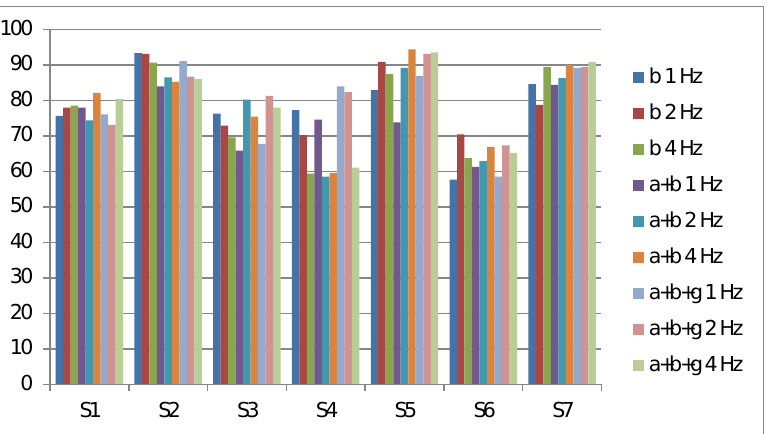
Figure 4. Accuracy comparison for each subject with different types of features. In the legends, a means α , b means β , and g means γ